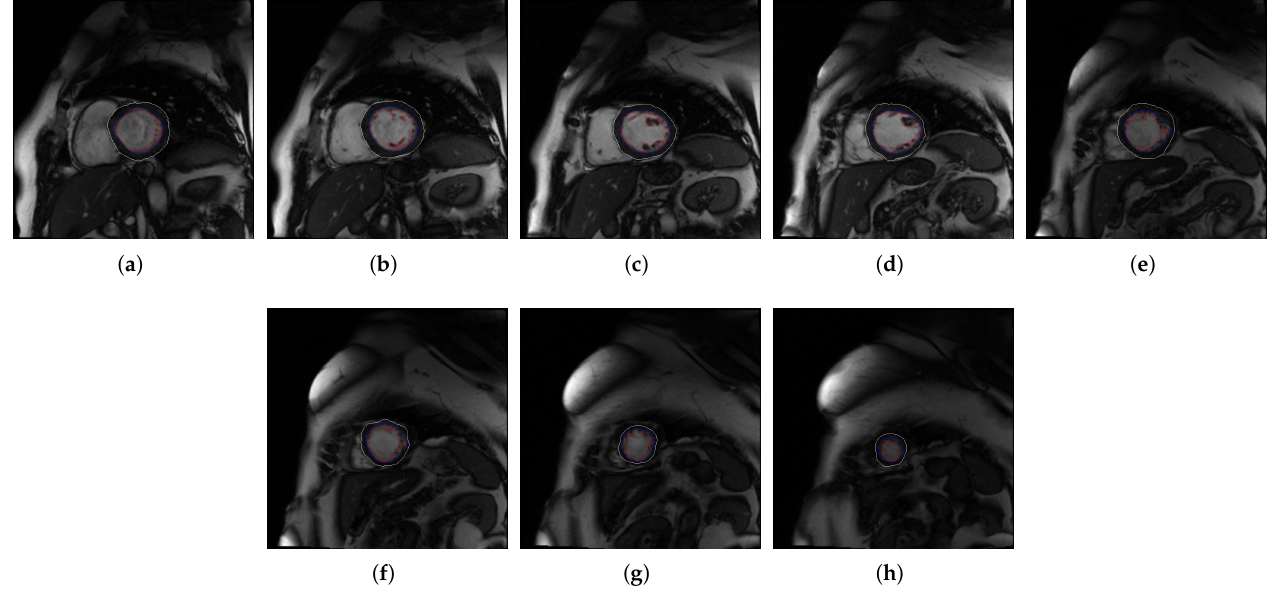
Figure 4. ( a – h ) Slices 1 to 8 of X5.